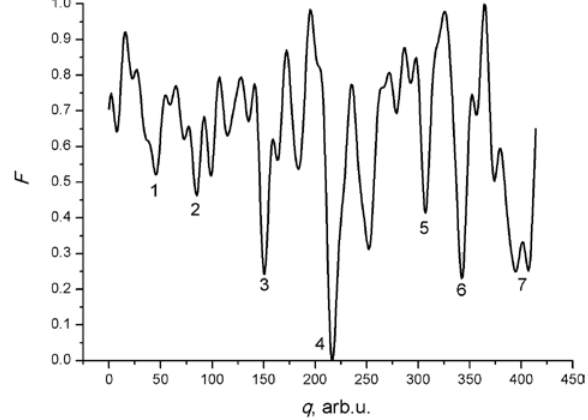
Fig. 5. Normalized Fourier spectrum F ( q ). S / N ≥ 10 (1 arb.u. ≈ 0.05 μm -1